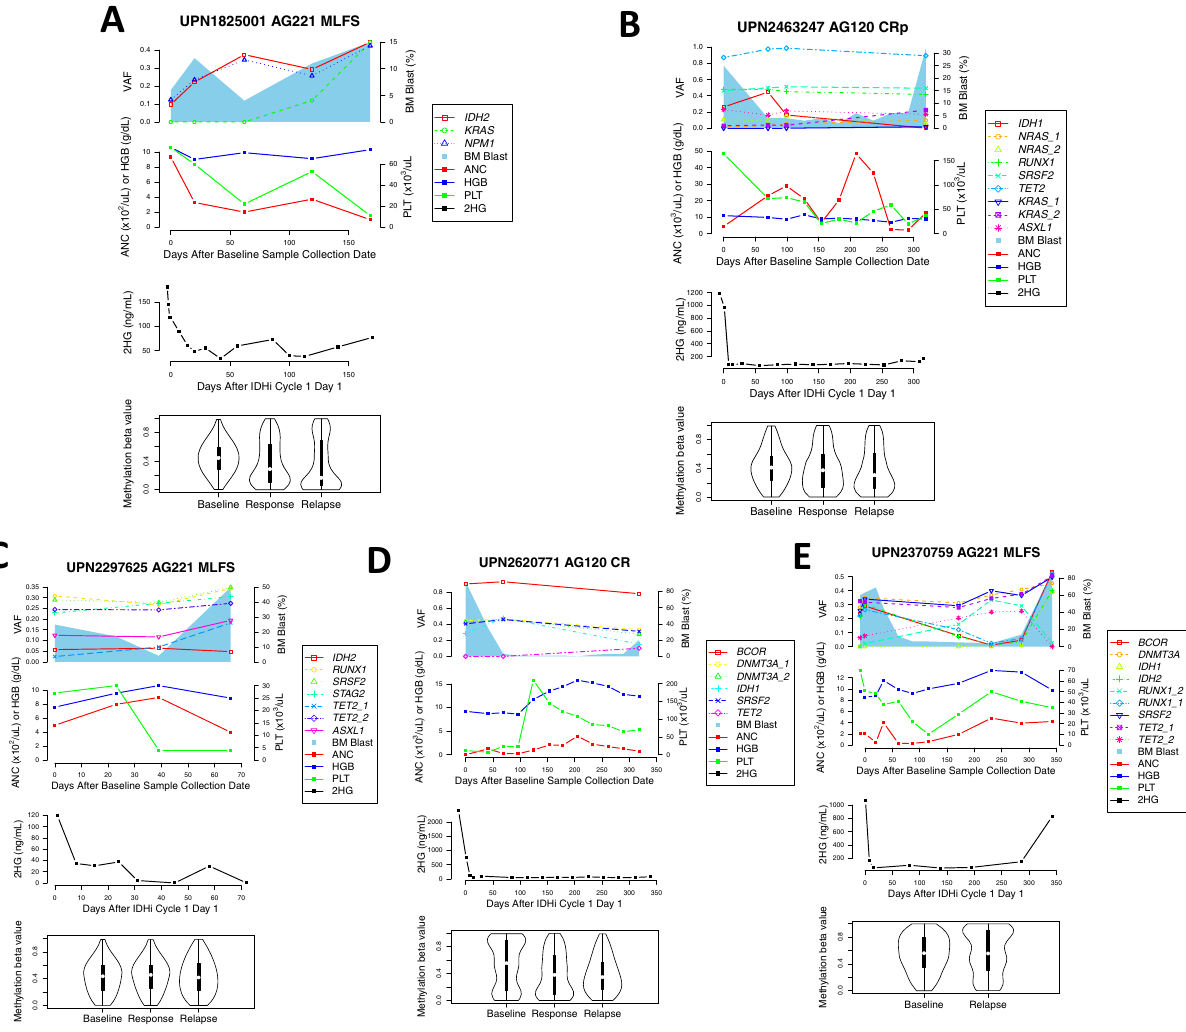
Fig. 6 Heterogeneous patterns of genetic and epigenetic evolution in AML patients treated with IDHi. A – E Multidimensional longitudinal plot of mutation VAFs, bone marrow (BM) blast counts, absolute neutrophil count (ANC), hemoglobin (HGB) counts, platelet (PLT) counts, 2HG level, and DNA methylation level in UPN1825001 ( A ), UPN2463247 ( B ), UPN2297625 ( C ), UPN2620771 ( D ), and UPN2370759 ( E ). Line plots show mutation VAFs, ANC/HGB/PLT counts, and 2HG level. Blue shades represent BM blast counts. Violin plots show the methylation distribution. Violin plot shows the minimum, fi rst quartile (Q1), median, third quartile (Q3), and maximum. Source data are provided as Source data fi les. libraries were then sequenced using a HiSeq 2000 sequencer (Illumina, San Diego, NCT01915498 (enasidenib for IDH2 -mutated patients) and NCT02074839 (ivo- CA) with 76 base pair paired-end reads. The median of median depth of the sidenib for IDH1 -mutated patients). Selection of the studied patients was based on targeted regions was 323× (IQR: 201× – 429×). the sample availability alone. Bone marrow mononuclear cells were collected Raw-sequencing data from the Illumina platform were converted to a fastq longitudinally (pretreatment, posttreatment, and relapse) from the trial participants format and aligned to the reference genome (hg19) using the Burroughs – Wheeler and were subject for the analyses. Clinical response to the therapy was determined by the clinical investigators and followed the modi fi ed 2003 International Working Aligner using MEM mode with following parameters: -k 31 -T 100 -t 8 -M. The Group criteria 26 . We de fi ned responders as having overall response to the therapy, aligned BAM fi les were subjected to mark duplication, realignment, and recalibration, using Picard and GATK with default parameters. Preprocessed BAM which included CR, CR with incomplete hematologic or platelet recovery, partial fi les were then analyzed to detect SNV and small insertions and deletions (indels), response, and MLFS. In MDS patients, hematologic improvement was also con- using MuTect and Pindel, respectively, against pooled unmatched normal sidered as response. Nonresponders were de fi ned as having stable disease or pro- sequences developed in house. gressive disease. Written informed consent for sample collection and analysis was We performed a series of fi ltering and annotation to identify high-con fi dence obtained from all patients. The study protocols adhered to the Declaration of driver mutations. First, variants with low-quality sequencing de fi ned by (1) tumor Helsinki and were approved by the Institutional Review Board at The University of coverage<15×, (2) tumor allele frequency<5%, and (3) normal allele frequency ≥ 1% Texas MD Anderson Cancer Center. Detailed information about the sample and 0% for SNVs and INDELs, respectively, were fi ltered out. Second, only variants availability is shown in Fig. S14. with obvious protein-coding change were kept for further analysis. Third, common polymorphisms with a population frequency of 0.14% in public variant databases, Targeted deep sequencing and mutation caling . We used a SureSelect custom including the 1000 Genome Database, ESP6500 Database, dbSNP ver.129, and Exome panel of 295 genes or All Exon Panel v6. (Agilent Technologies, Santa Clara, CA; Aggregation Consortium database, were removed. Finally, an hierarchical Table S2) 27 . For samples analyzed by exon panel, the analysis was restricted to the classi fi cation system was developed to assign con fi dence level for each remaining 295 genes. When available, clinical sequencing data were also used. Brie fl y, variant in order to facilitate the identi fi cation of putative oncogenic driver mutations. genomic DNA was extracted from bone marrow mononuclear cells using an Speci fi cally, each variant was classi fi ed based on the following hierarchical order and Autopure extractor (QIAGEN/Gentra, Valencia, CA). DNAs were fragmented and was assigned a con fi dence level corresponding to its rank in the system: (1) con fi rmed bait-captured in solution according to manufacturer ’ s protocols. Captured DNA NATURE COMMUNICATIONS| (2021) 12:2607 |https://doi.org/10.1038/s41467-021-22874-x|www.nature.com/naturecommunications